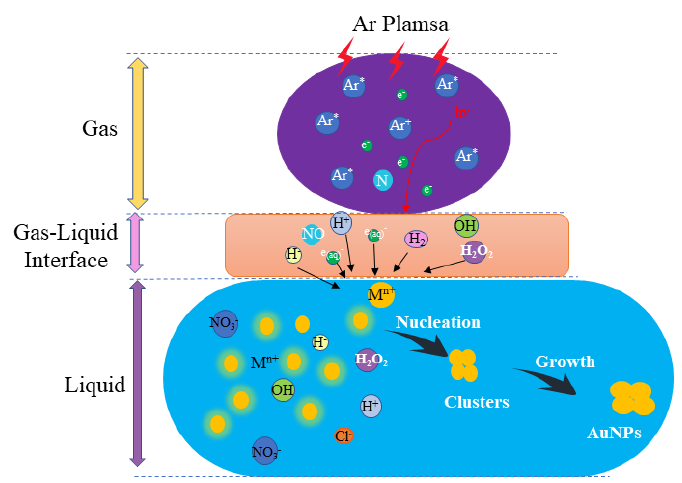
Figure 16. Schematic diagram of the synthesis mechanisms for plasma–liquid interaction.